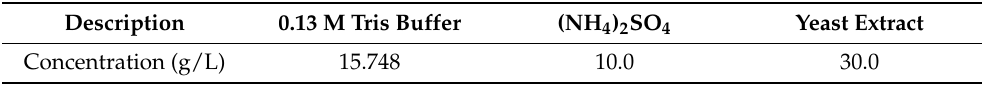
Table 1. ATCC 1376 NH 4 -YE medium